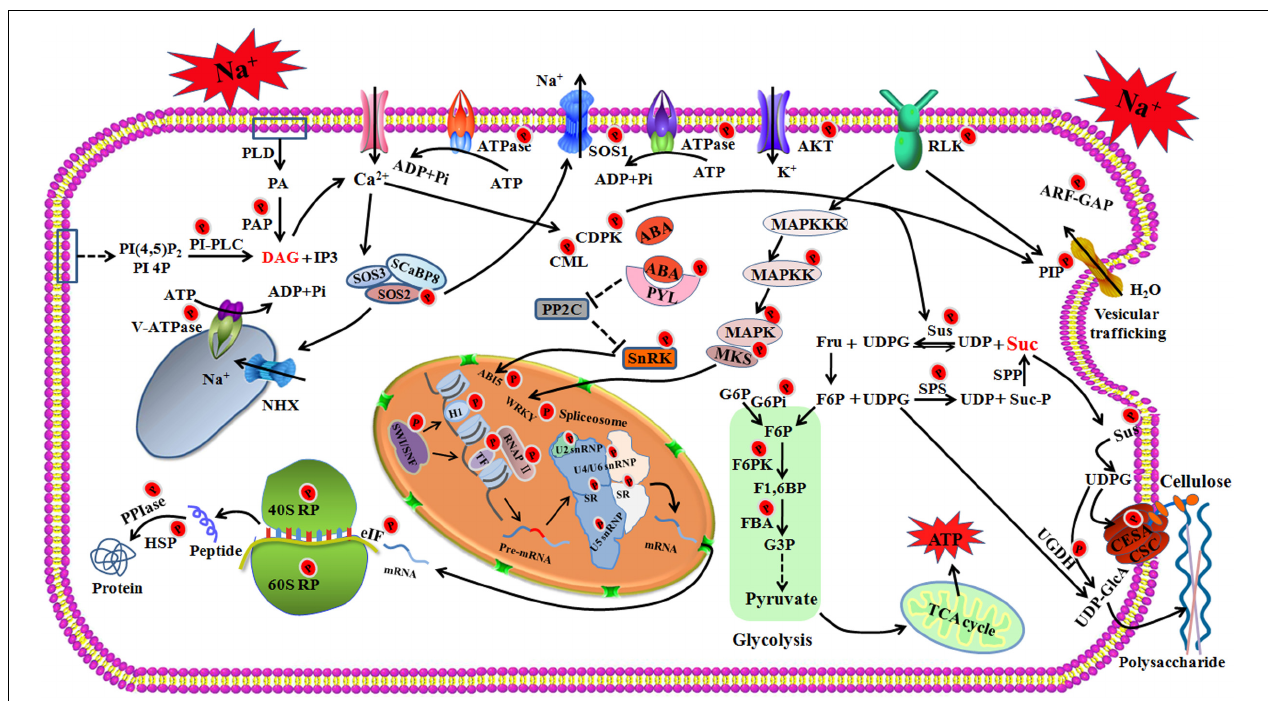
FIGURE 8 | The schematic presentation of salt-responsive mechanisms in the root of foxtail millet. RLK, receptor-like protein kinase; SOS, salt overly sensitive; SCaBP8, SOS3-Like calcium binding protein 8; AKT, potassium transporter; MAPK, Mitogen-activated protein kinase; MAPKK, Mitogen-activated protein kinase kinase; MAPKKK, Mitogen-activated protein kinase kinase kinase; PP2C, protein phosphatase 2C; PYL, abscisic acid receptor; PLD, phospholipase D; PA, Phosphatidic acid; PAP, phosphatidate phosphatase; DAG, Diacylglycerol; PI(4,5)P2, phosphatidylinositol 4,5-bisphosphate; PI4P, phosphatidylinositol-4-phosphate; IP3, inositol 1,4,5-trisphosphate; PI-PLC, Phosphoinositide phospholipase C; hnRNPs, Heterogeneous nuclear ribonucleoproteins (hnRNPs); snRNPs, Small nuclear ribonucleoproteins (snRNPs); SR, serine/arginine-rich splicing factor; RP, ribosomal protein; eIF, Eukaryotic translation initiation factor; PPIase, peptidyl-prolyl cis-trans isomerase; HSP, heat shock protein; SuS, Sucrose synthase; SPS, Sucrose phosphate synthase; SPP, sucrose phosphate phosphatase; Suc, Sucrose; Suc-P, Sucrose 6-phosphate; Fru, Fructose; UDPG, Uridine diphosphate glucose; UDP, uridine diphosphate; F6P, fructose 6-phophate; F1,6BP, fructose 1,6-bisphosphate; G6Pi, Glucose-6-phosphate isomerase; G6P, Glucose-6-phosphate; FBA, Fructose-bisphosphate aldolase; F6PK, ATP-dependent 6-phosphofructo kinase; CSC, cellulose synthase complex; CESA, cellulose synthase A; UGDH, UDP-glucose dehydrogenase; UDP-GlcA,